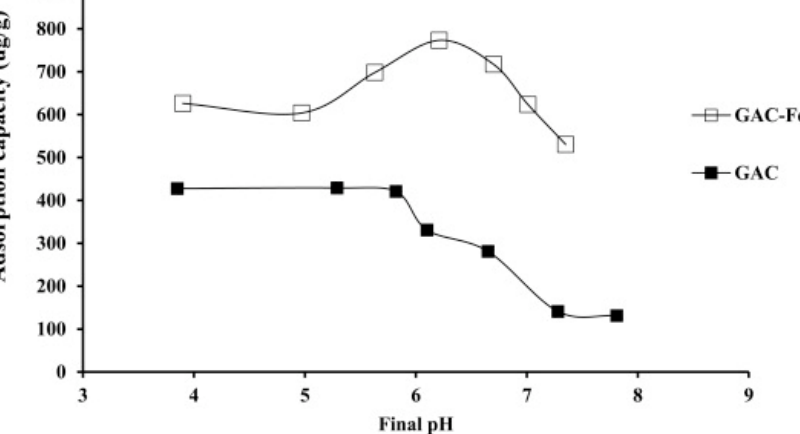
Figure 5. Effect of pH on arsenic adsorption on both GAC and iron-impregnated GAC. Reprinted from Kalaruban et al. [24] Copyright 2021 Elsevier.